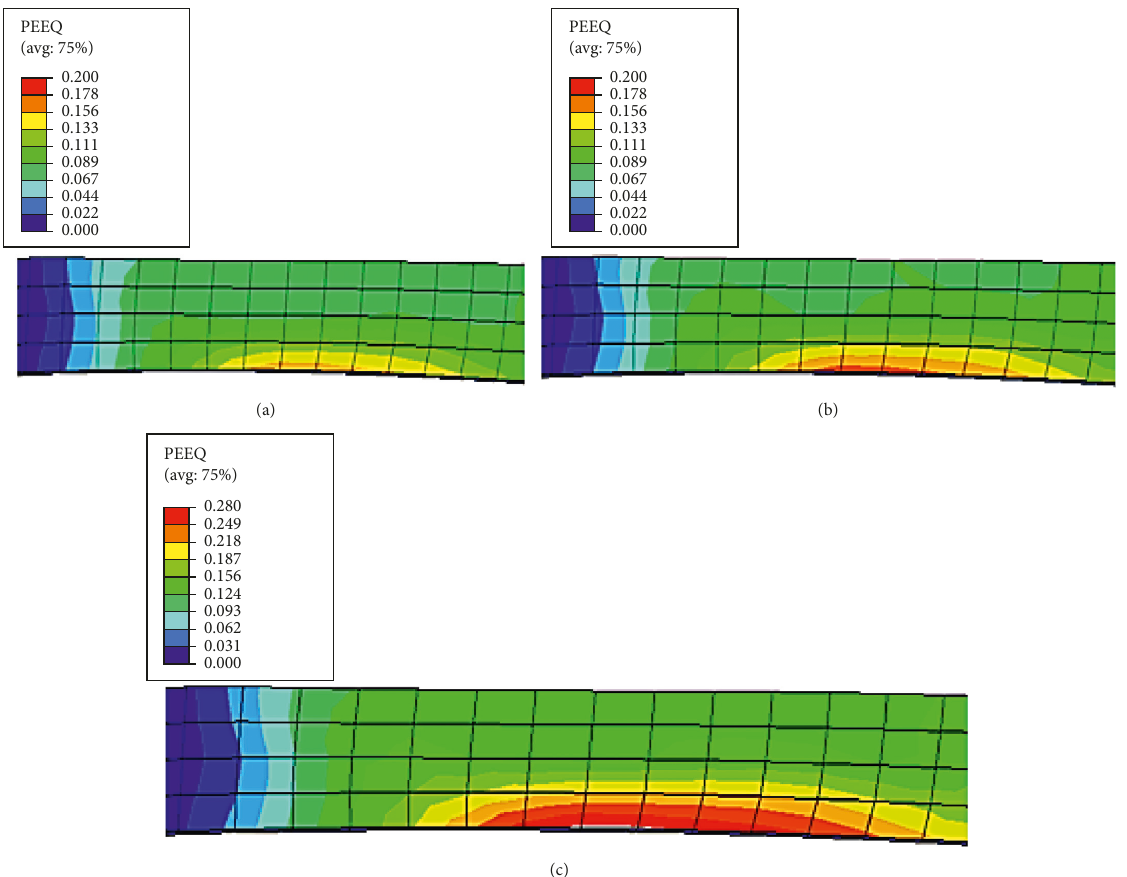
Figure 15: The distribution of equivalent deformations in the thermal deformation hearth in electrocontact surfacing of a steel tape at K v 1.015 and the duration of a current impulse: t imp (cid:31)